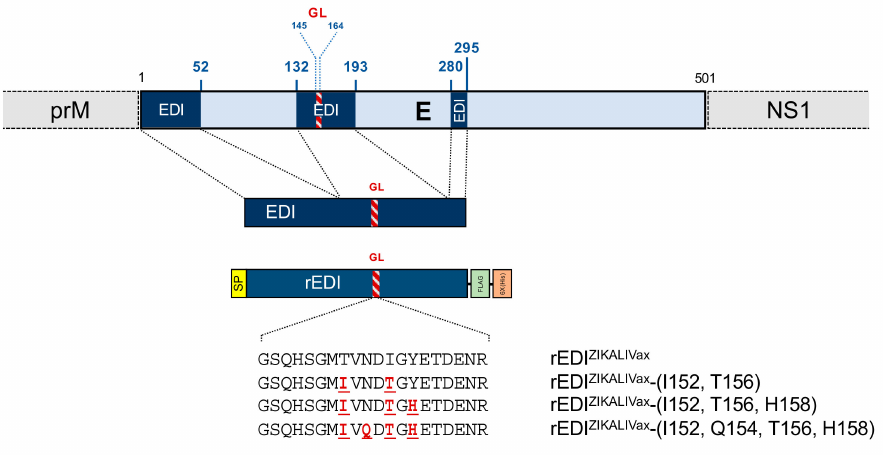
Figure 6. Schematic representation of ZIKALIVax rEDI constructs. The organization of the E protein into ZIKV polyprotein with its three segments composing the EDI domain is shown on top. The EDI residues are numbered as those in the E protein of ZIKALIVax. The glycan loop (GL) sequence of E is shown as a red, hatched segment. The rEDI ZIKALIVax sequence is preceded by a N-terminal heterologous signal peptide (SP) and followed by the spaced two C-terminal FLAG and 6x(His) tags in tandem. The rEDI ZIKALIVax gene was inserted into plasmid vector pcDNA3. Directed mutagenesis was performed on rEDI ZIKALIVax sequence to generate three mutants. The amino-acid substitutions introduced into rEDI ZIKALIVax are indicated in red